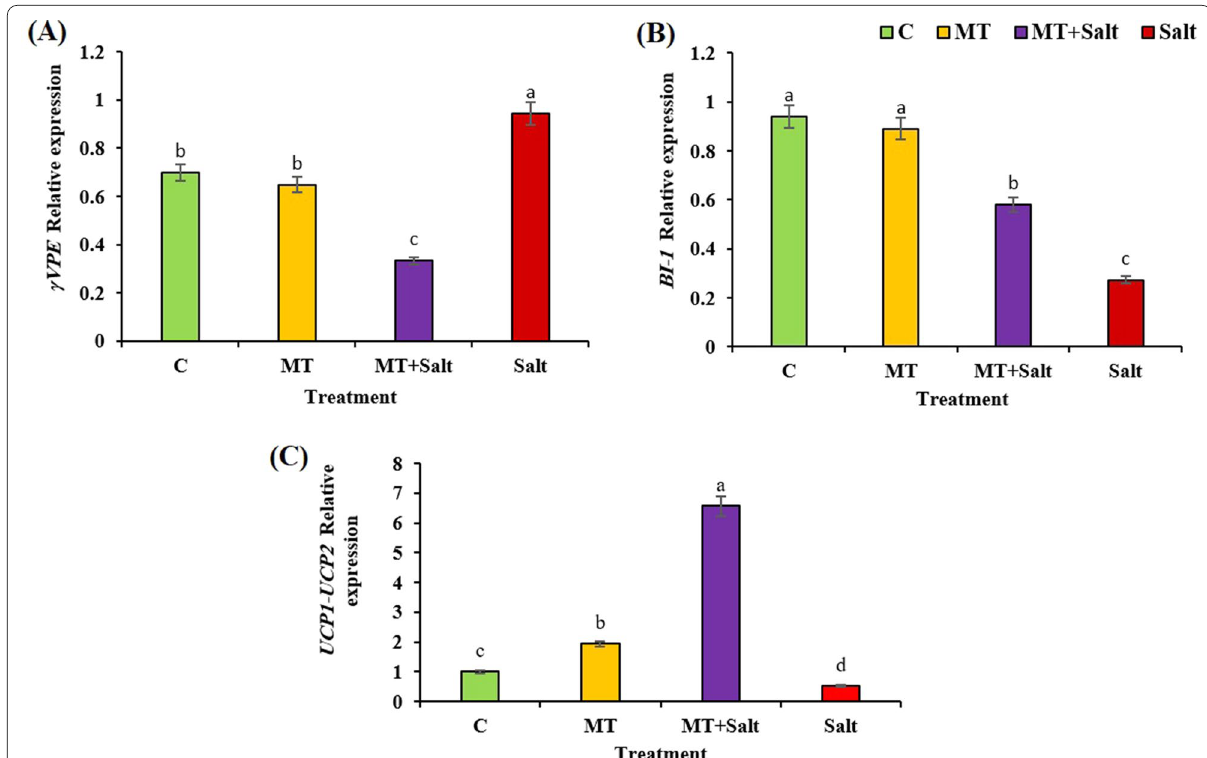
Fig. 5 Relative expression of γVPE ( A ), BI-1 ( B ), and UCP1-UCP2 ( C ) genes in alfalfa root meristem after ten days’ treatment with salt and melatonin. Data represents the mean of replicates SD and uncommon letters indicate significant difference based on Duncan’s multiple range test (P < 0.05). ± C Control; MT, 0.1 µM melatonin treatment; Salt, 300 mM NaCl treatment; MT Salt, 0.1 µM melatonin and 300 mM NaCl +